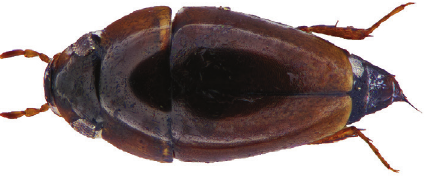
Figure 38. Limnebius probus Perkins, 2015 0.9 mm, iSimangaliso Wetland Park, False Bay (site 27), January 2015 DT Bilton, MS Bird & R Perissinotto